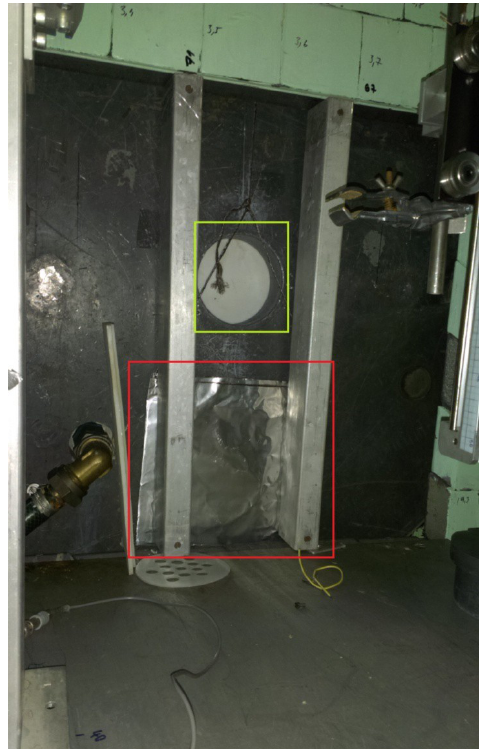
Figure 6. The neutron image plate (in the red frame) located in the default position below the enter of the BNCT horizontal channel (green frame).